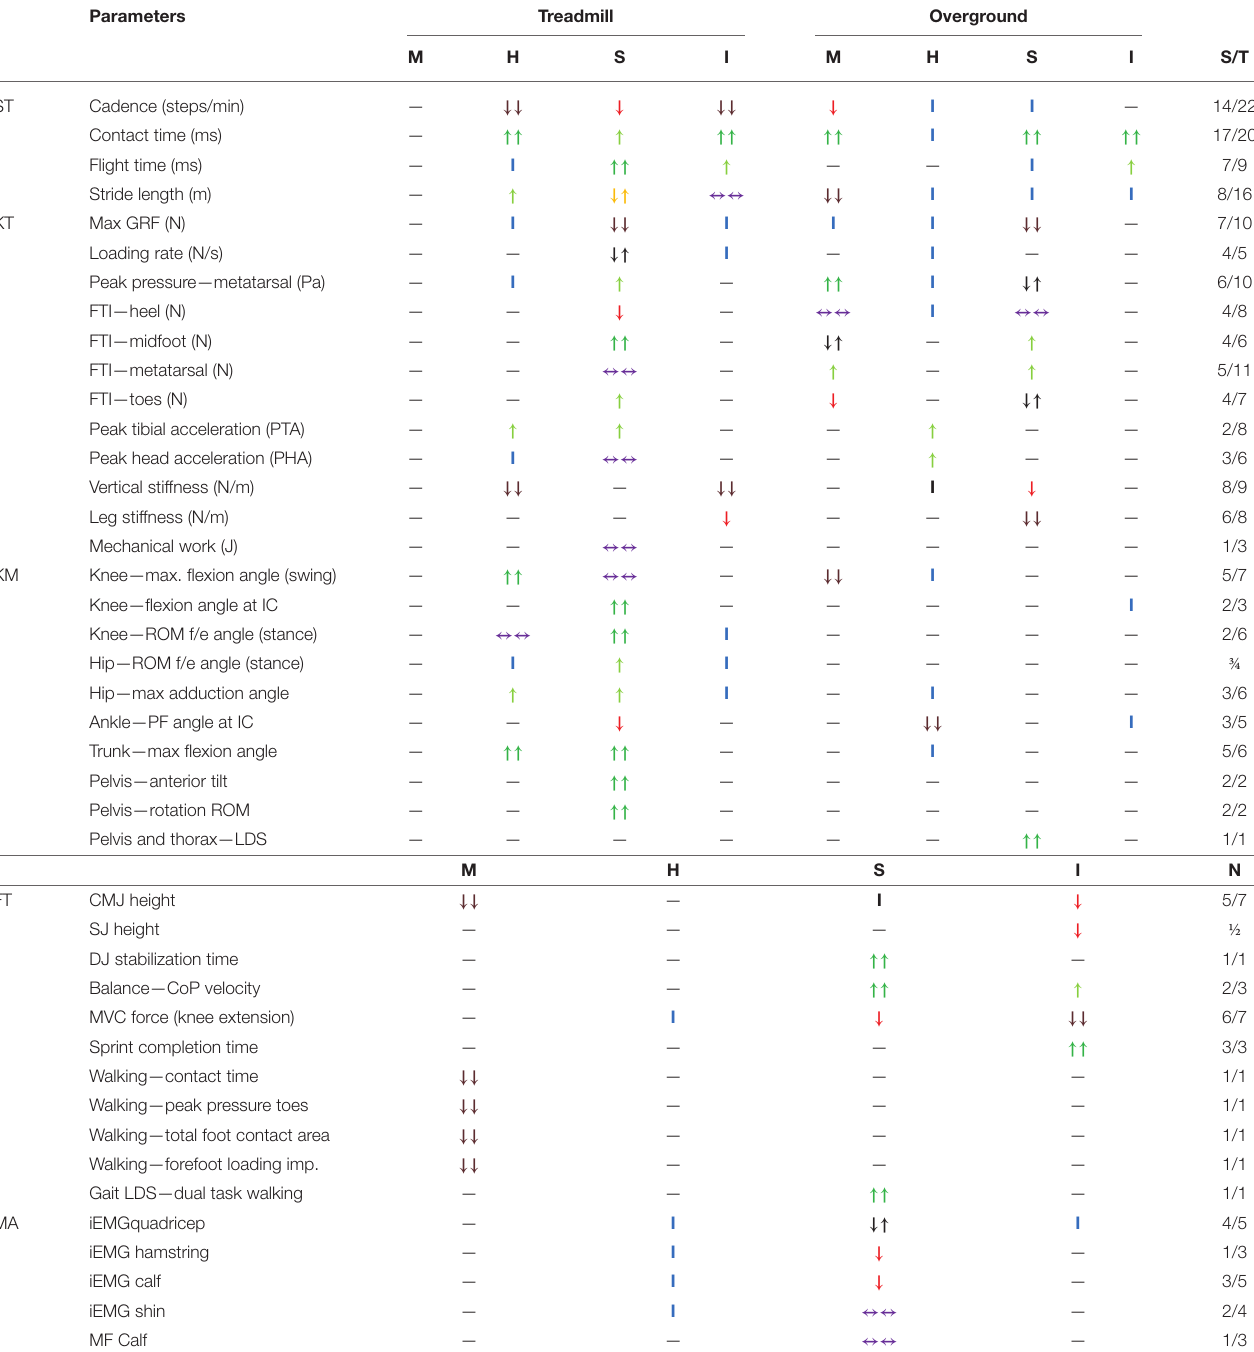
TABLE 2 | Parameters trends across different protocols.